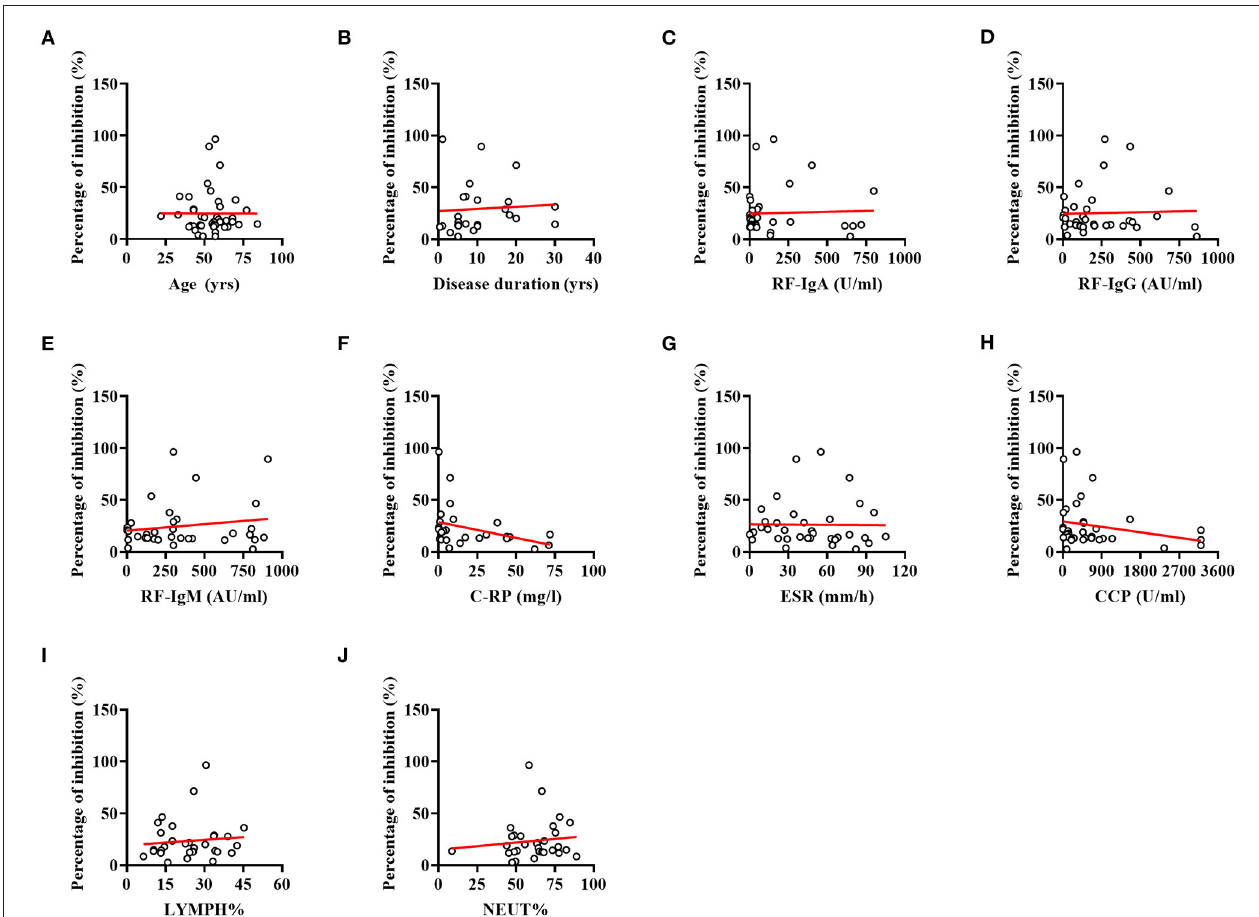
FIGURE 3 | Correlations between indices for RA and percentage of inhibition. (A) Correlation between the age of patients and percentage of inhibition. (B) Correlation between the disease duration and percentage of inhibition. (C) Correlation between the RF-IgA and percentage of inhibition. (D) Correlation between the RF-IgG and percentage of inhibition. (E) Correlation between the RF-IgM and percentage of inhibition. (F) Correlation between the C-RP and percentage of inhibition. (G) Correlation between the ESR and percentage of inhibition. (H) Correlation between the Anti-CCP antibody and percentage of inhibition. (I) Correlation between the LYMPH% and percentage of inhibition. (J) Correlation between the NEUT% and percentage of inhibition. No significant correlations were evident between indices for RA and percentage of inhibition (all p -values >